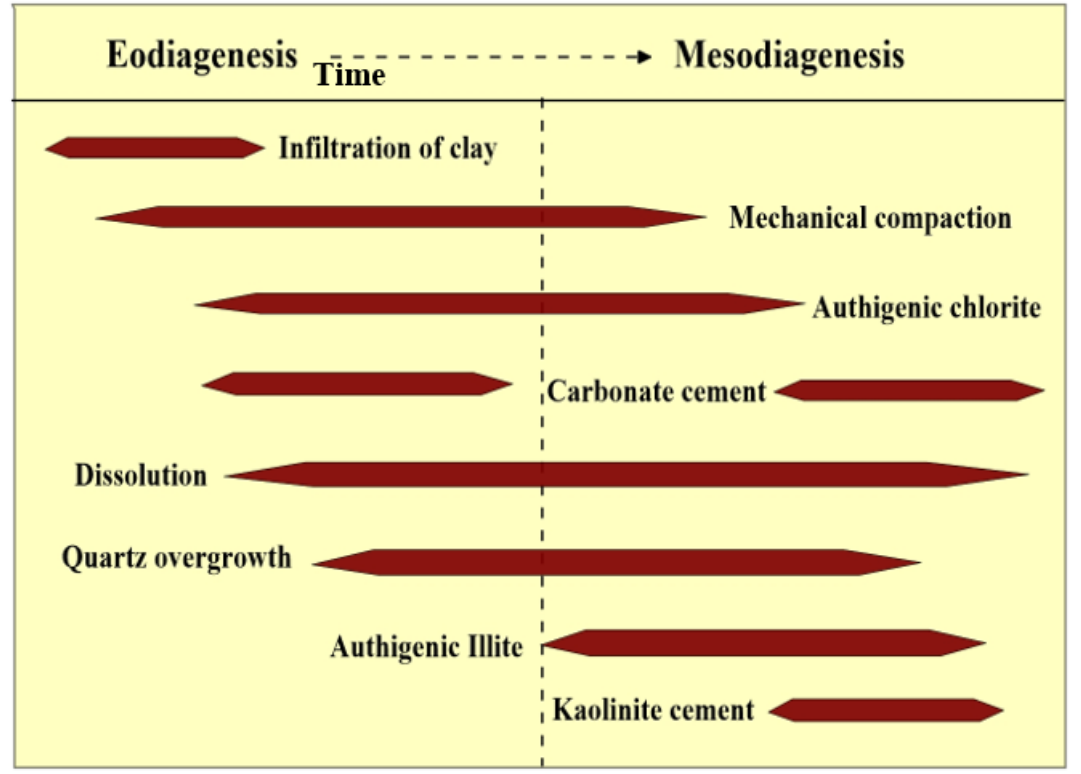
Figure 12. Paragenetic sequence of diagenetic features observed in the Neogene sandstones of the Srikail Gas Field. Srikail Gas